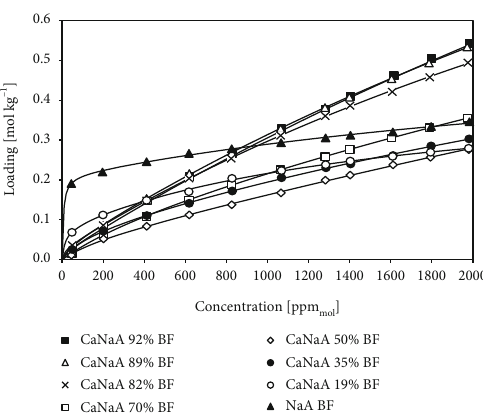
Figure 5: H S adsorption isotherm on LTA zeolites of di ff erent 2 cation exchange degrees at 85 °